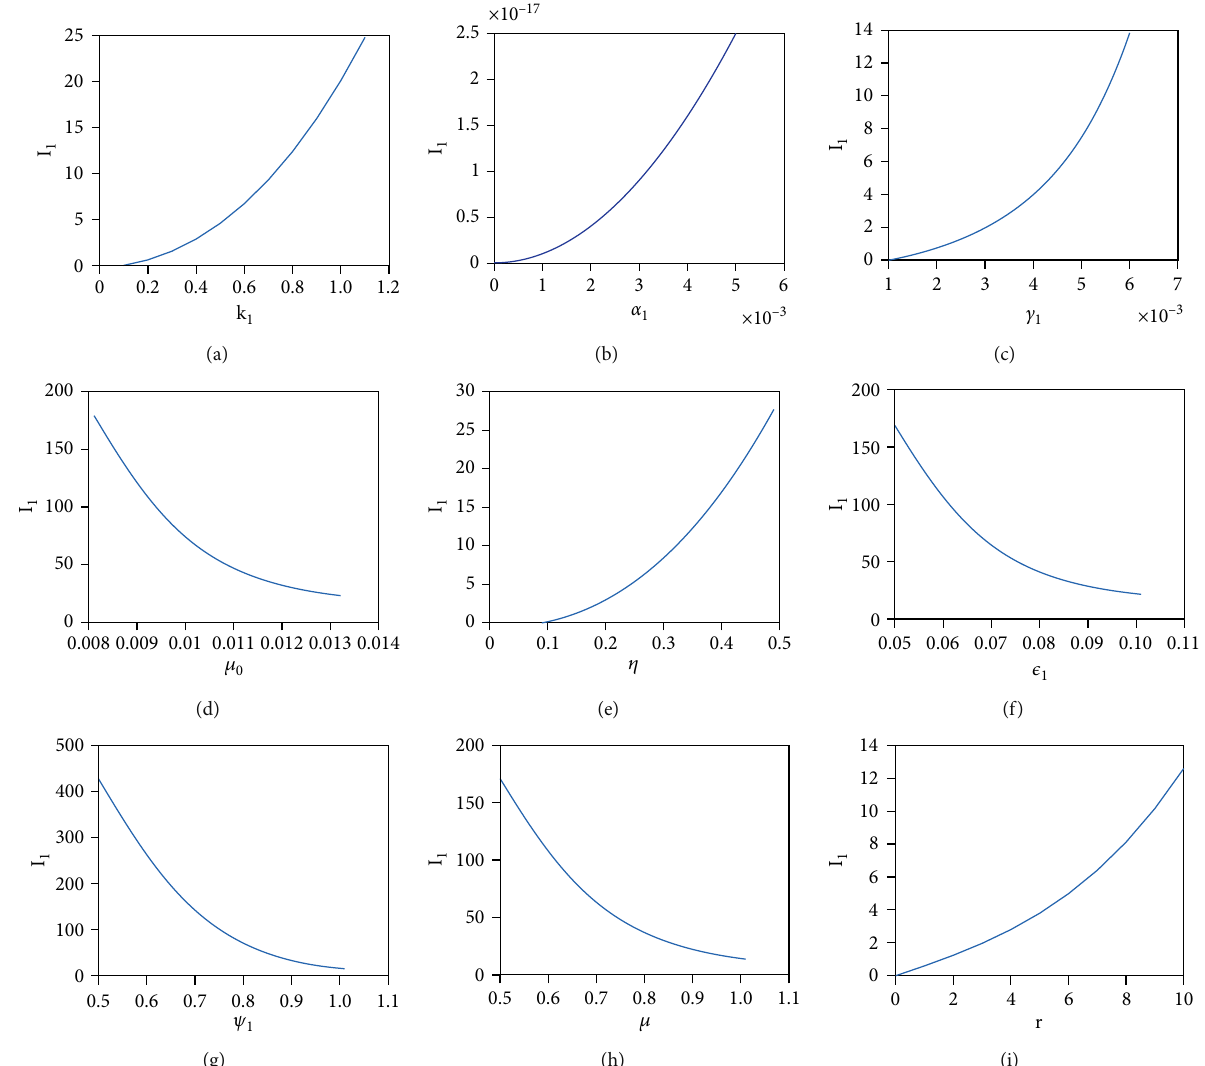
Figure 11: Figure of monotonicity test to the parameters of system (1) – (4) vs. infected